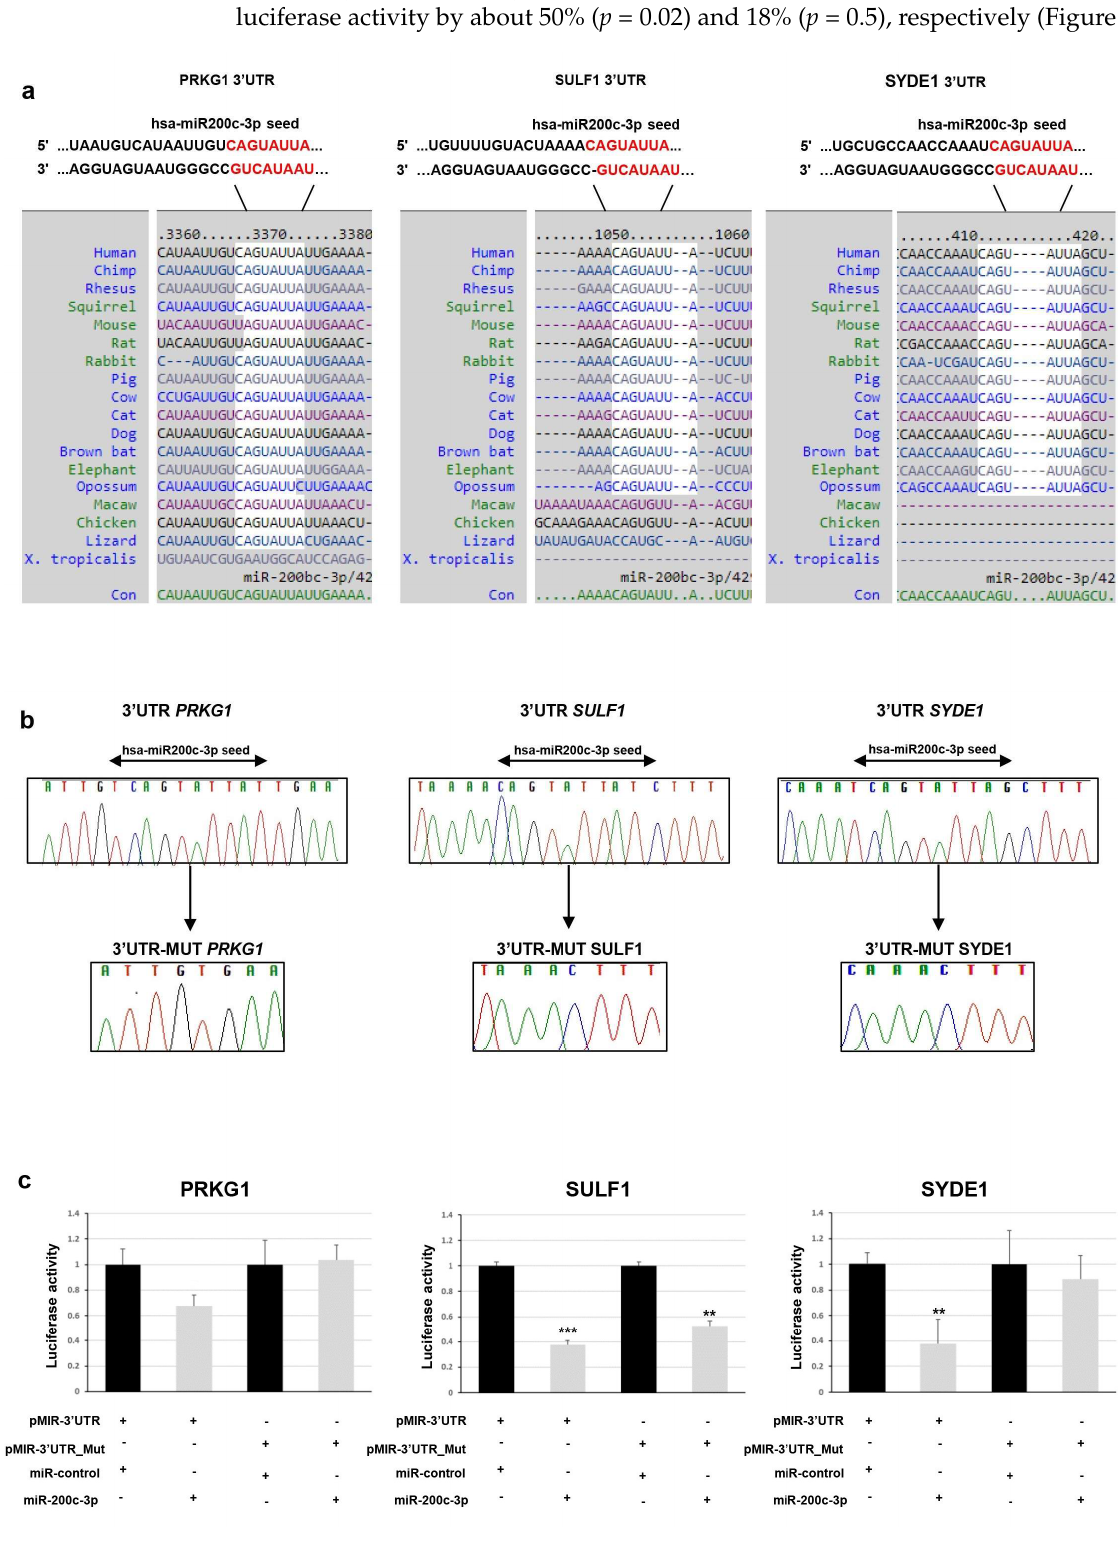
Figure 1. ( a ) Predicted pairing of hsa-miR-200c-3p seed sequence with its target genes is highlighted (upper panel). Positions 3368–3375 of PRKG1 3′-UTR, 1052–1059 of SULF1 3′-UTR, and 413–420 of